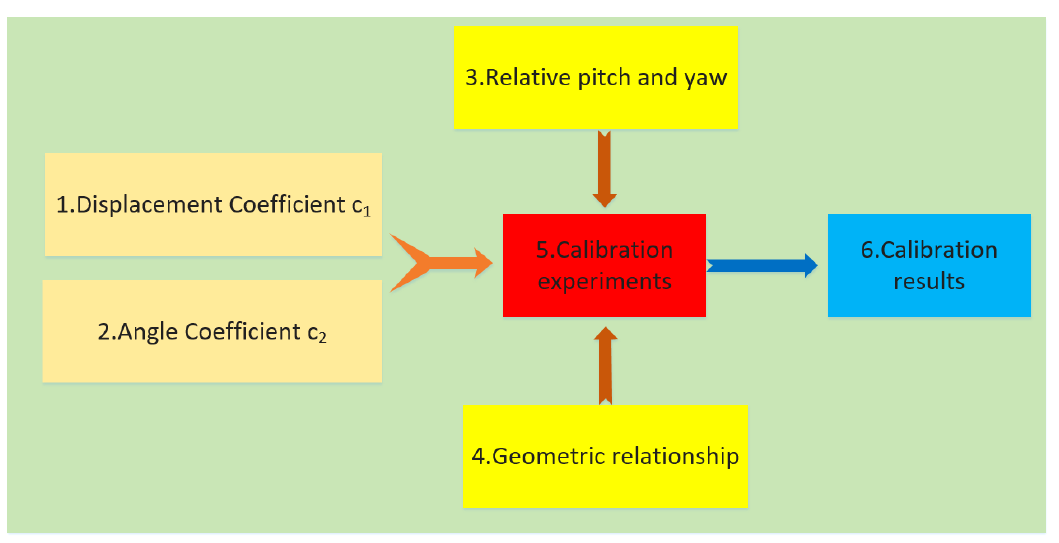
Figure 7. Calibration procedure.